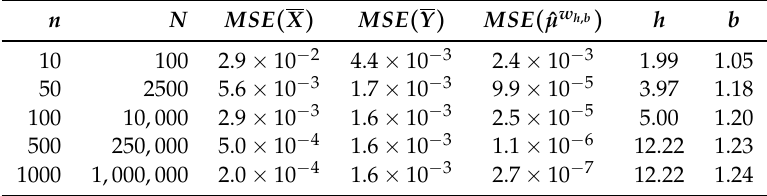
Table 1. MSE of the different estimators and optimal bandwidths obtained from the simulation study.